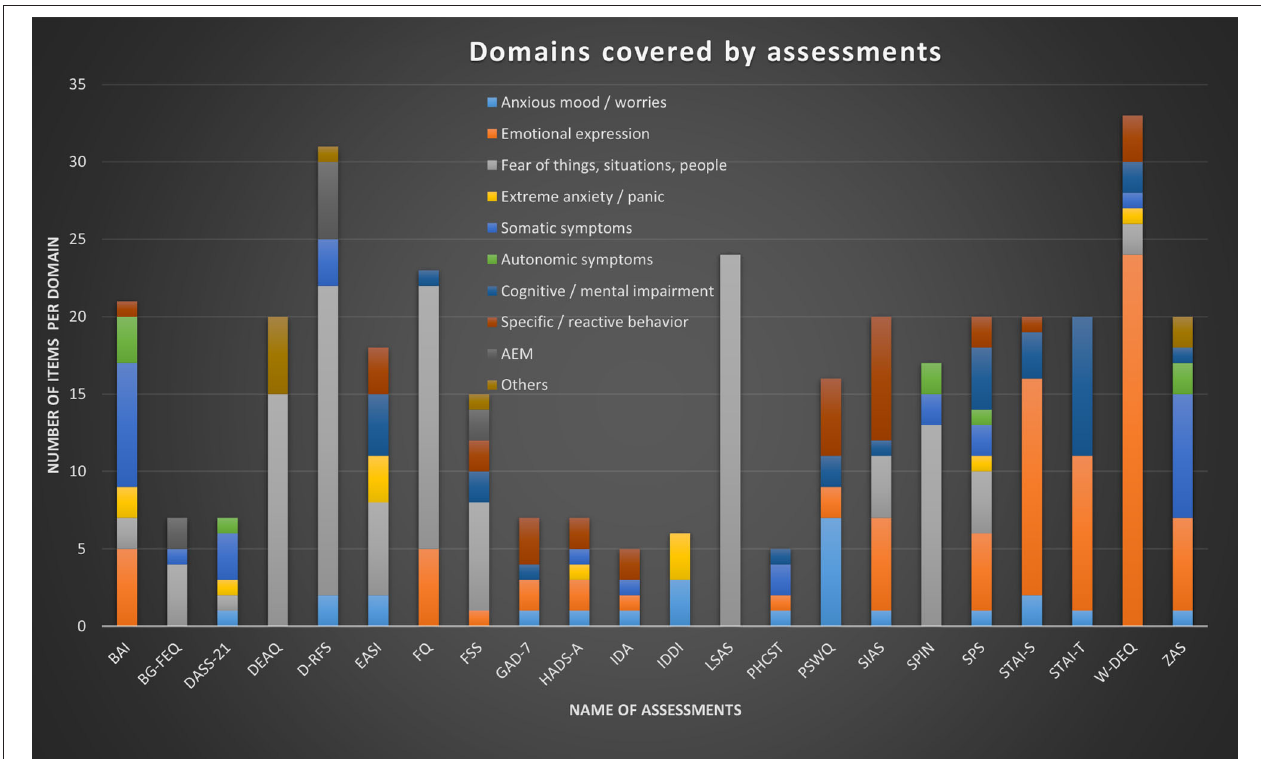
FIGURE 3 | Summary of our findings illustrating and comparing 22 different self-report questionnaires that are in use for the assessment of anxiety in PWE. It illustrates the number of items per questionnaire and their allocation to the domains we have extracted. We have not included the short versions of GAD-7 and EASI (GAD-2, GAD-SI, and brEASI) in this